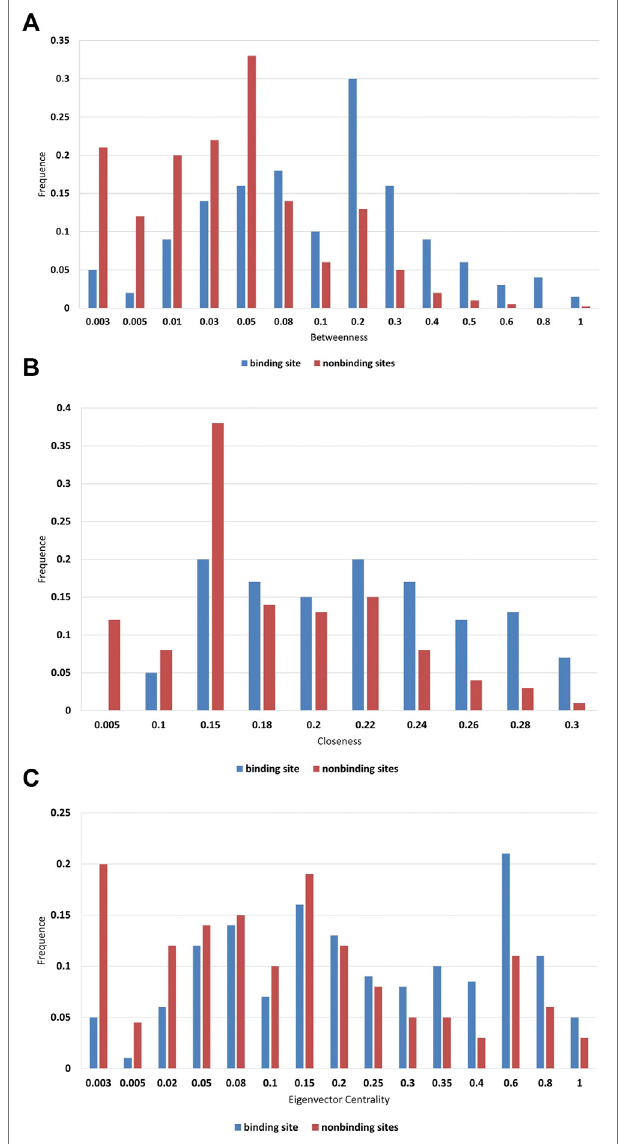
FIGURE 3 | Frequency distributions of (A) betweenness; (B) closeness; and (C) eigenvector